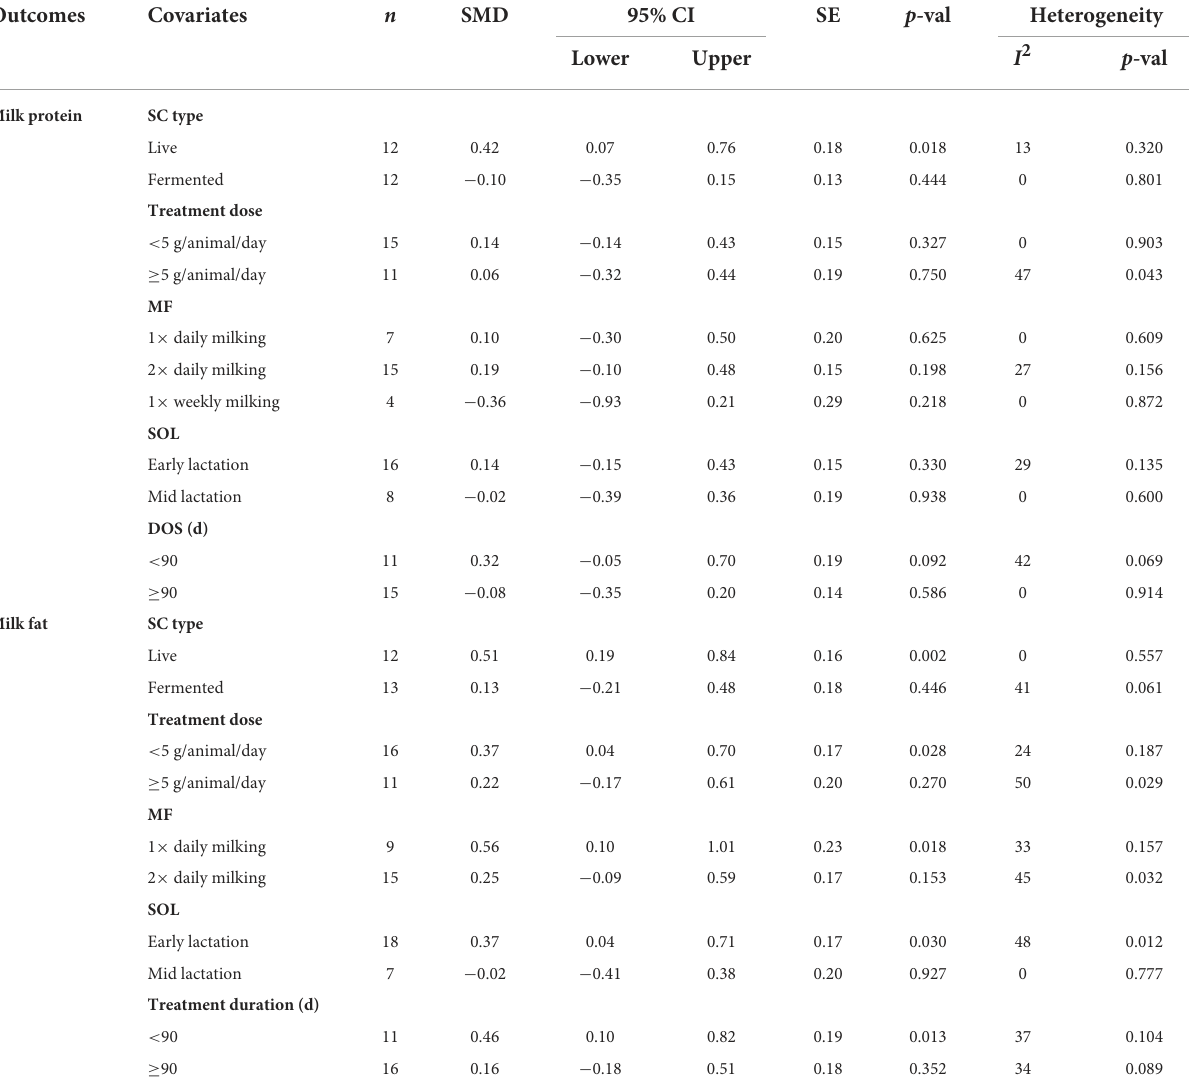
TABLE 4 Effect of covariates on milk protein and fat of lactating goats fed SC supplemented diets. Outcomes Covariates